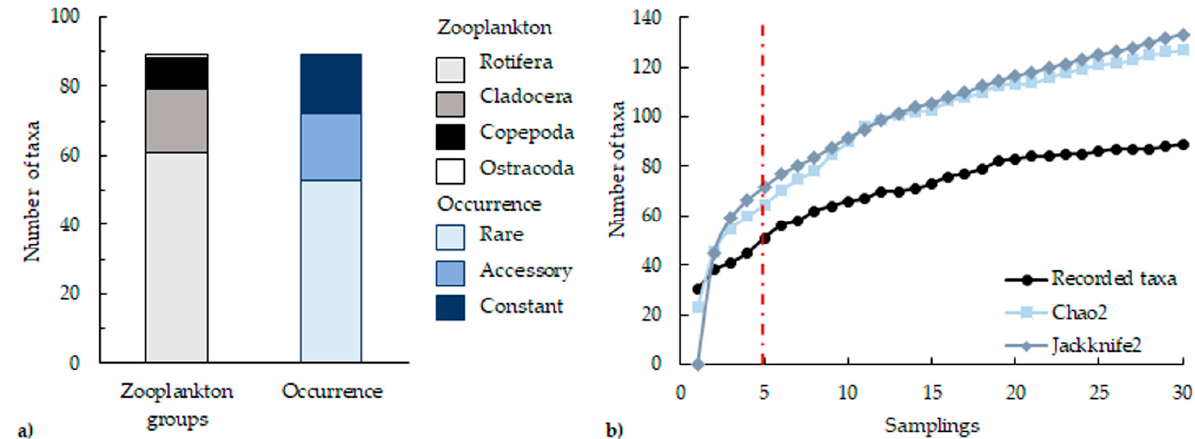
Figure 2. ( a ) Contribution of zooplankton group and occurrence’s groups to the total recorder taxa, ( b ) estimation of diversity using Chao2 and Jackknife2; red dashed line indicates the end of the impoundment period.